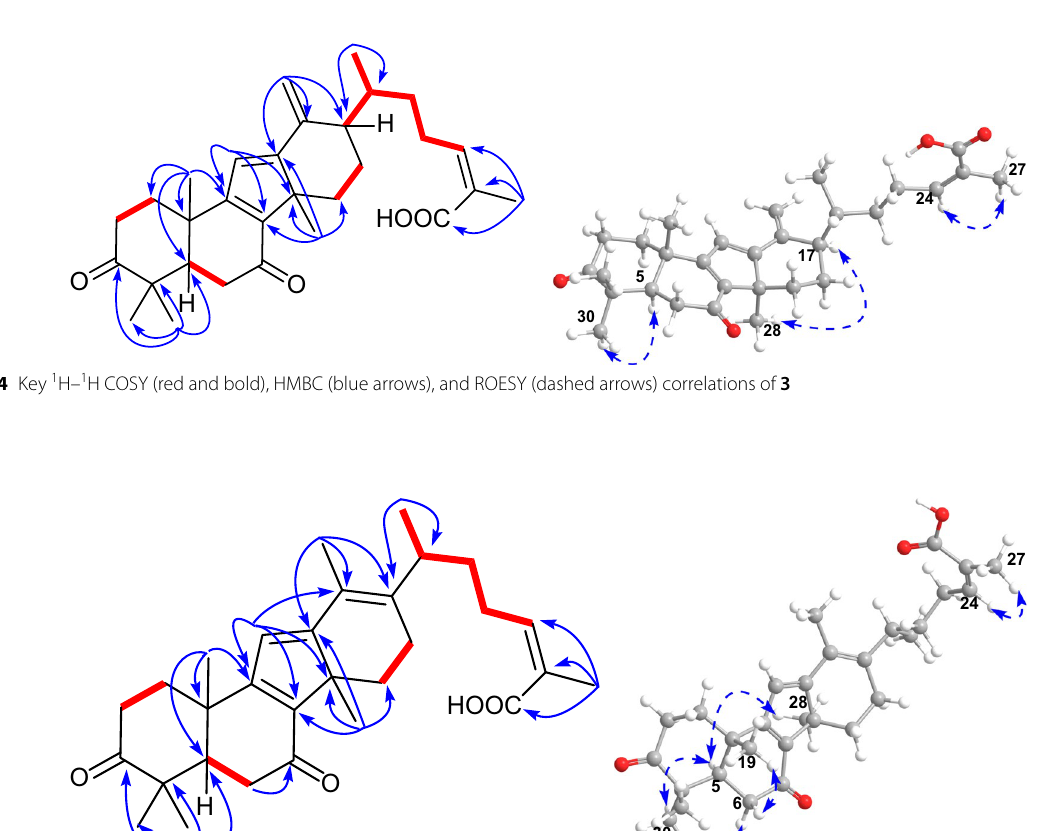
HO Fig. 5 Key 1 H– 1 H COSY (red and bold), HMBC (blue arrows), and ROESY (dashed arrows) correlations of